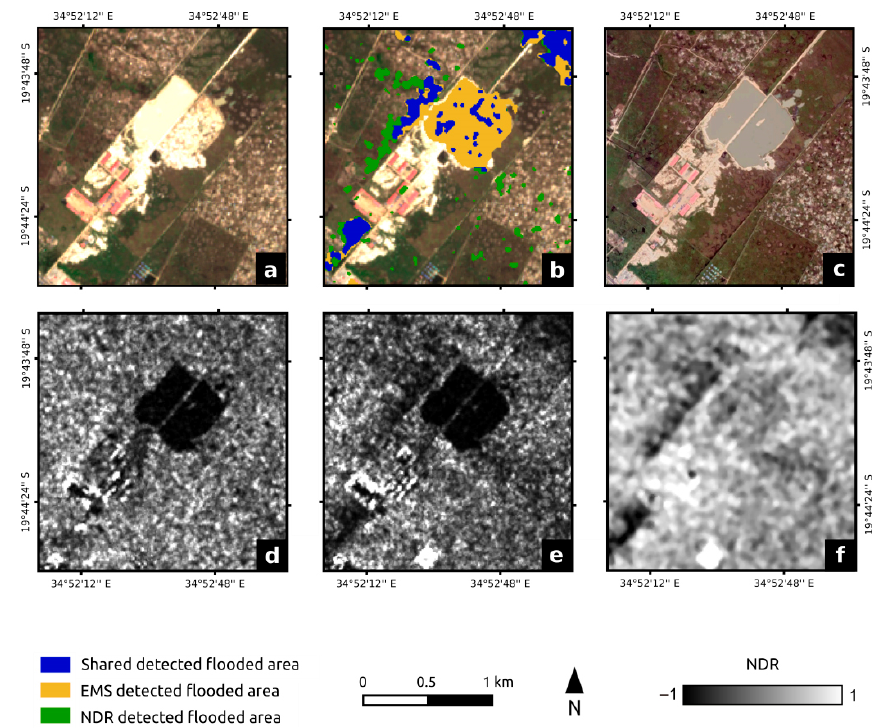
Figure 9. Flood detection comparison between NDR and EMS Copernicus in Beira area.